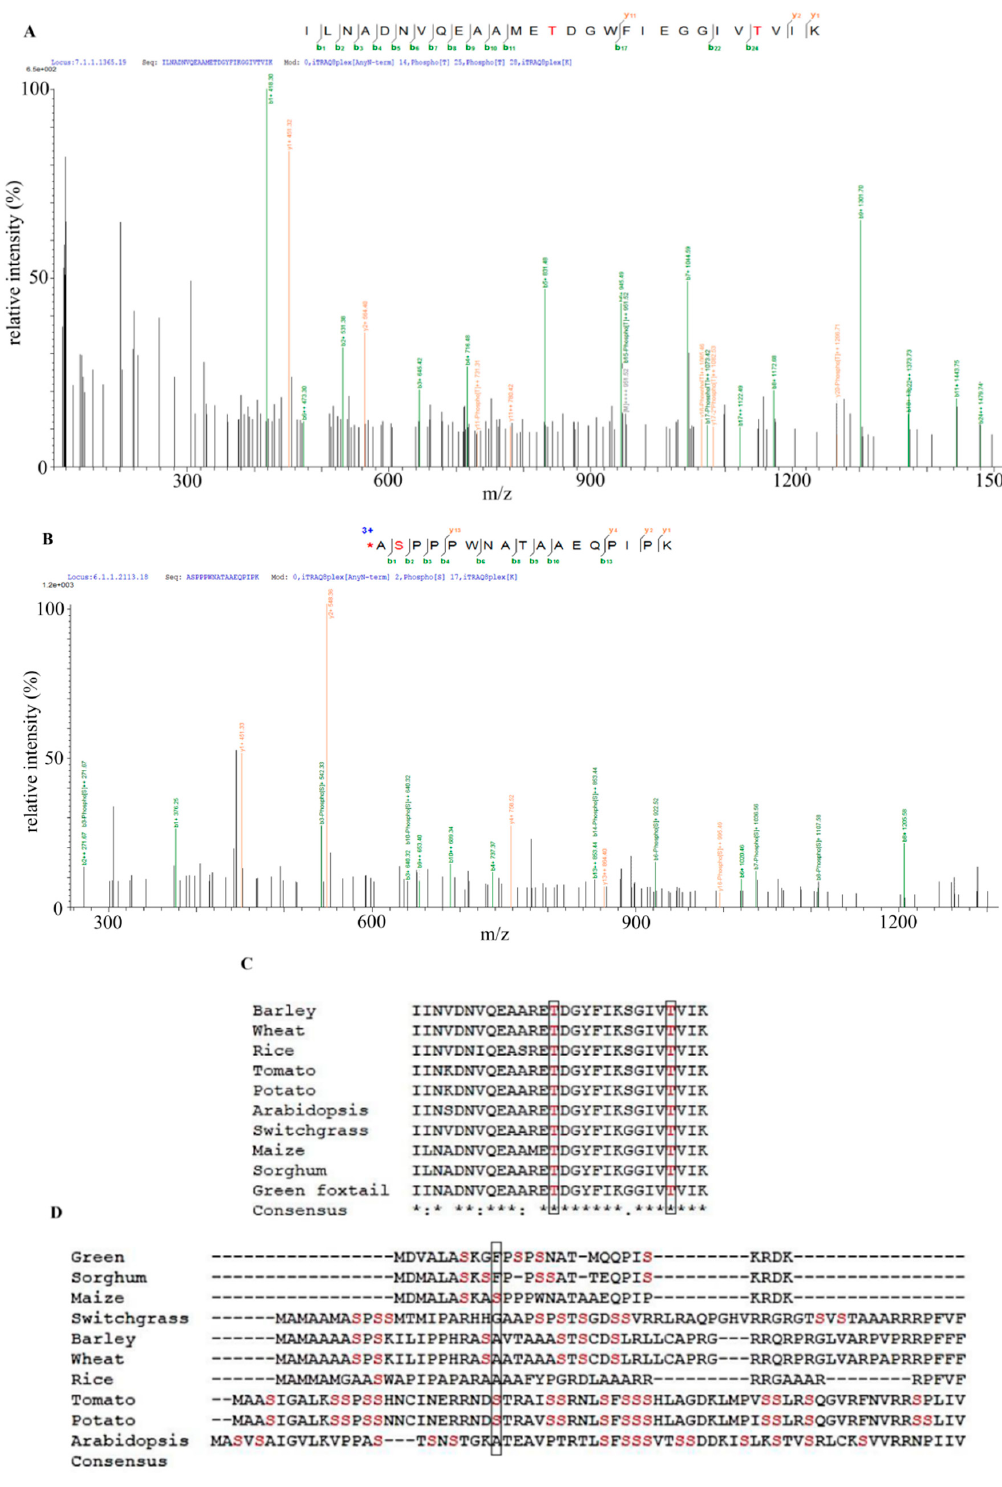
Figure 6. Identification of Bt2 phosphorylation sites by iTRAQ TM . ( A , B ) Mass spectrometry diagram of Bt2 phosphopeptides. Red letters S and T show the phosphorylated serine and threonine. ( C , D ) Multiple alignment analysis of phosphorylated sites of maize Bt2 at Ser 10 , Thr 451 , and Thr 462 in indicated species by ClustalX 2.1. software. The frame shows the phosphorylated sites identified in maize Bt2 position and putative position in other species. Asterisk shows the consensus of the protein sequence.